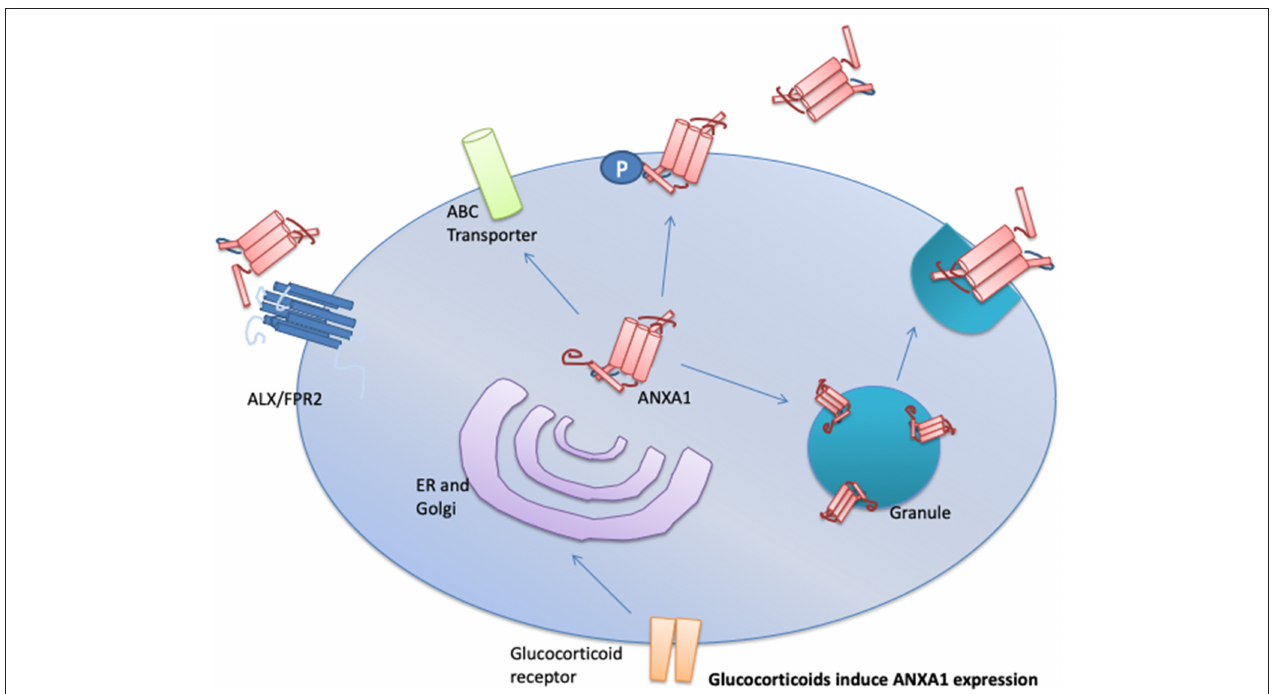
FIGURE 1 | Upon cellular activation, ANXA1 is mobilized to the plasma membrane and then secreted in one of three mechanisms depending in the cell type involved. These mechanisms are: (1) through the ATP-binding (ABC) transporter; (2) via direct phosphorylation of ANXA1 on serine-27 followed by membrane localization to the plasma membrane, and (3) fusion of ANXA1 loaded granules to the plasma membrane. Once released ANXA1 can act in an autocrine, paracrine, and juxtacrine manner to activate ALX/FPR2